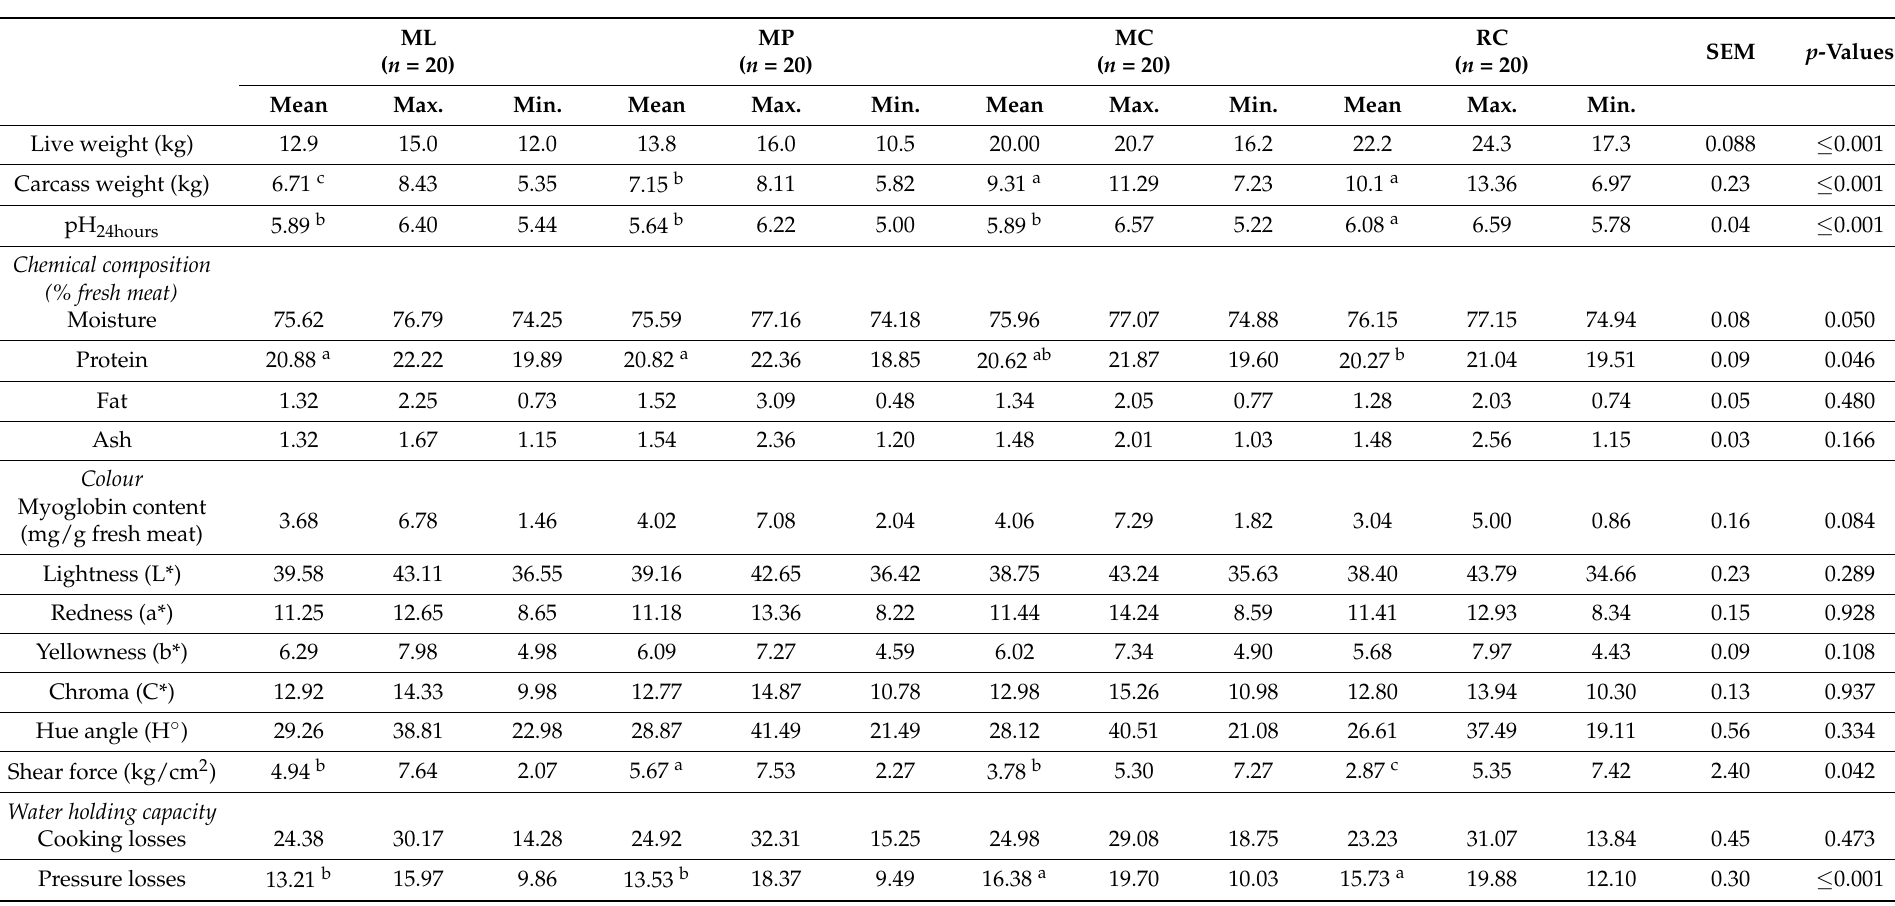
Table 2. Descriptive statistics (mean, maximum and minimum) for meat-quality characteristics in Mallorquina lambs suckling (ML), grazing (MP) or supplemented with grain (MC); and Roja Mallorquina lambs supplemented with grain